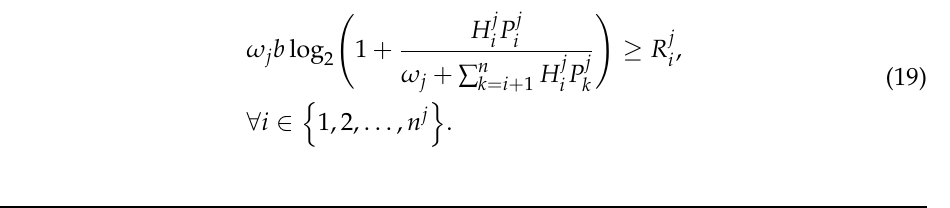
Algorithm 1 Inter-cluster dynamic programming